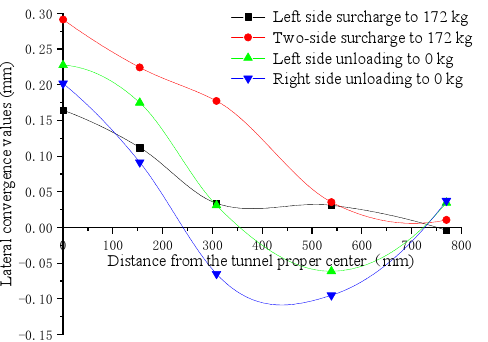
Figure 7. Transverse convergence deformation of each measurement point in each surcharge stage in Case 1.